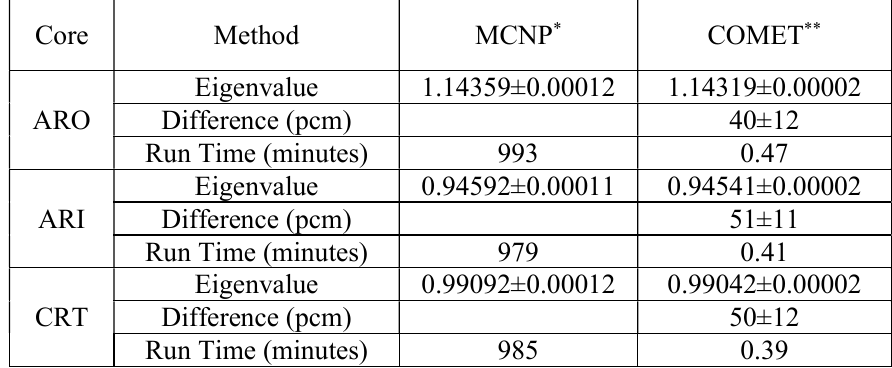
Table II. Comparison of the core eigenvalues and computation